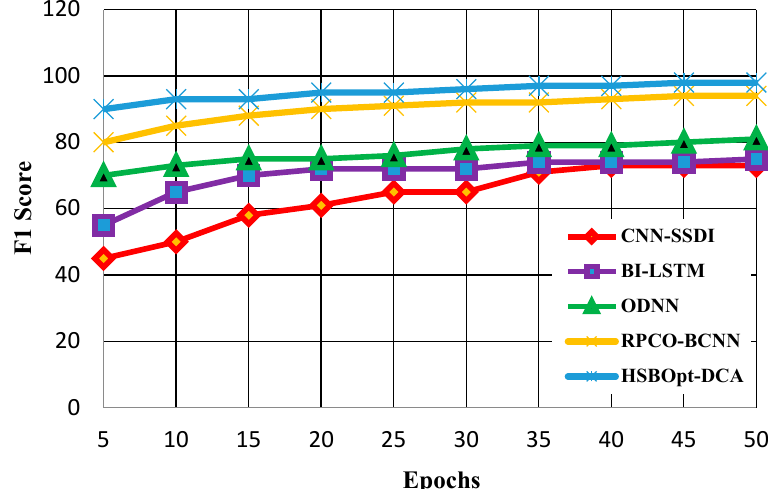
Figure 9. F1-score calculation with 50 epochs.